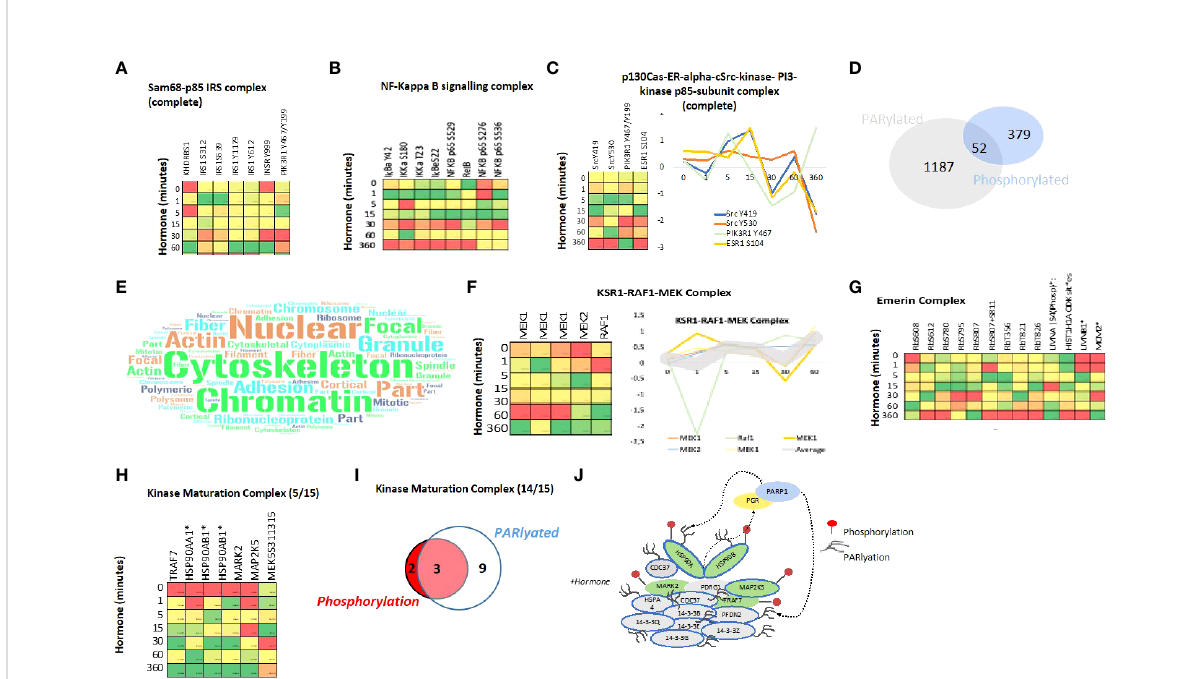
FIGURE 4 Protein Complex analysis and Overlap of PARylation and Phosphorylation in response to Progesterone. Heatmaps showing the phosphorylation of proteins within the Sam68-p85 IRS (A) and NF-kappa B (B) signalling complexes in response to hormone over time. (C) Heatmap showing the phosphorylation of proteins of the p130 Cas-ER-Src-PI3K complex in response to hormone over time, the coordinated phosphorylation of each phosphosite individually is represented as a line graph (right panel). (D) Venn diagram showing the overlap of proteins which contain either a phosphorylation site (379), PARylation site (1187) or both PTMs within the same protein after hormone exposure in T47D cells (52). (E) Word cloud representation showing the GO-cellular component enrichment analysis of the 52 proteins identi fi ed as phosphorylated and PARylated in response to hormone (D) . (F) Heatmap showing the phosphorylation of components of the KRS1-RAF1-MEK signalling complex in response to hormone over time, all proteins shown are phosphorylated and PARylated and the dynamics of individual sites is shown on the right panel. (G) Heatmap showing the phosphorylation proteins of the Emerin complex in response to hormone over time. (H) Heatmap showing the phosphorylation of proteins (5/ 15) within the Kinase Maturation complex in response to hormone over time, phosphorylation dynamics of individual sites is shown (lower panel). (I) Venn diagram showing the phosphorylation and or PARylation of proteins contained within the kinase maturation complex; 14/15 protein components of the complex contain at least one of the PTMs. (J) Schematic representation of the complex components, PARylated proteins are indicated by blue circle, Phosphorylated by red (right panel). *Indicates proteins which are also